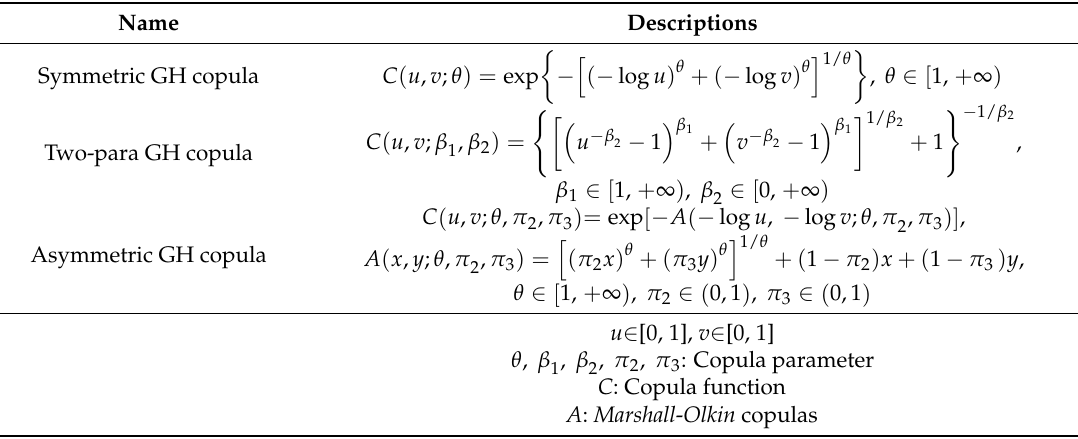
Table 1. Summary of the three candidate GH copula